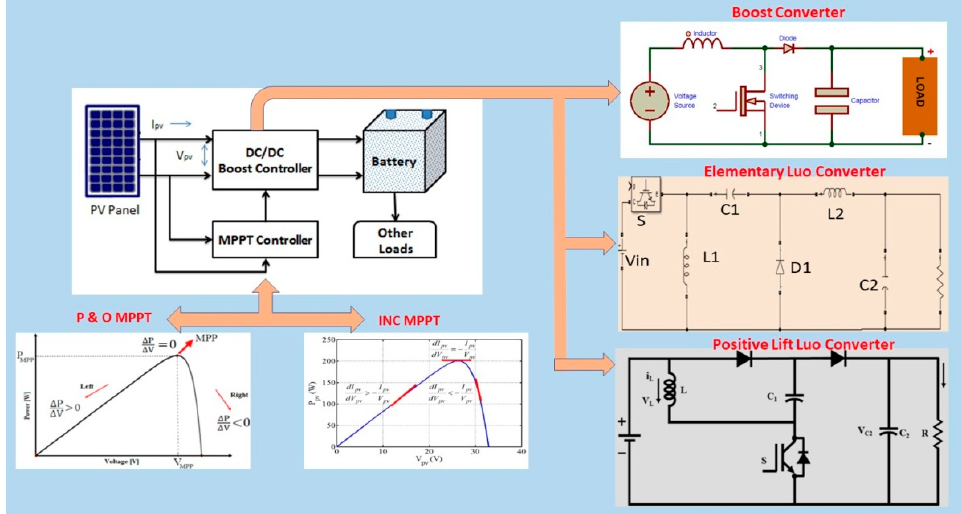
Figure 2. Different DC–DC boost converters and MPPT techniques.